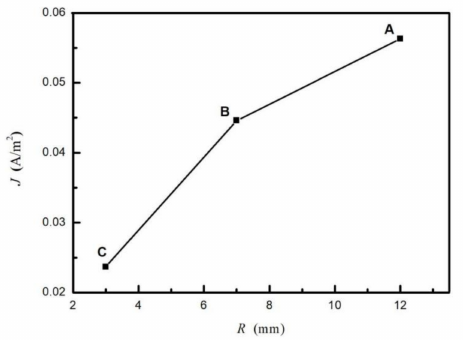
Figure 9. The curve of deposition current density distribution along the radial of alumina-Co composite film shown in Figure